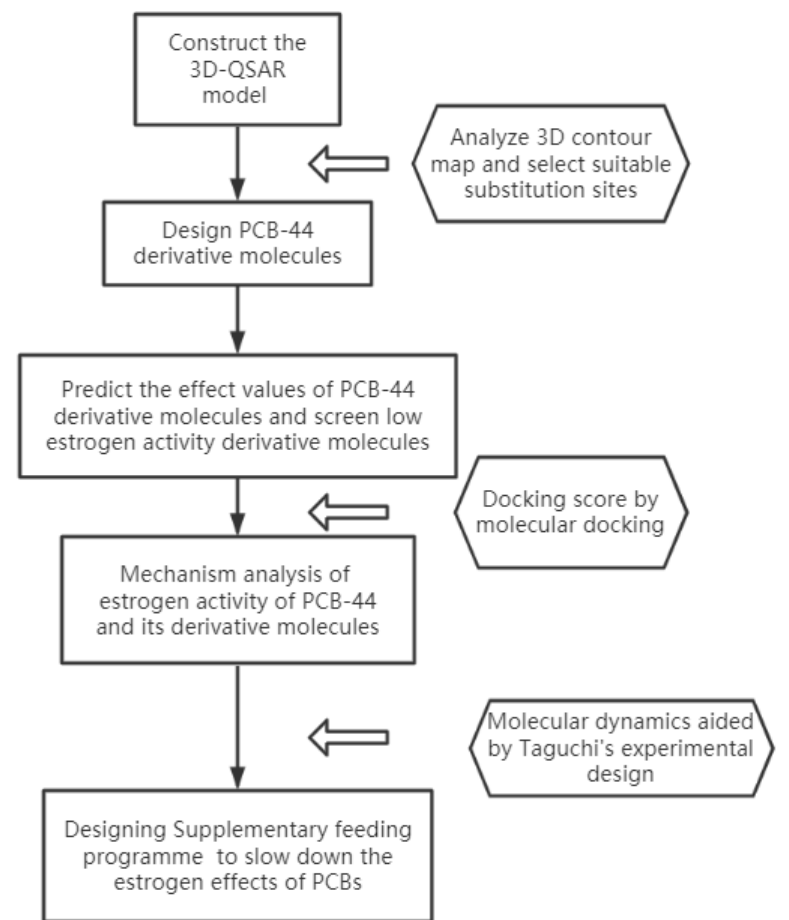
Figure 1. Flow chart of the risk mechanism of PCBs estrogenic activity and its regulation based on molecular modifications.